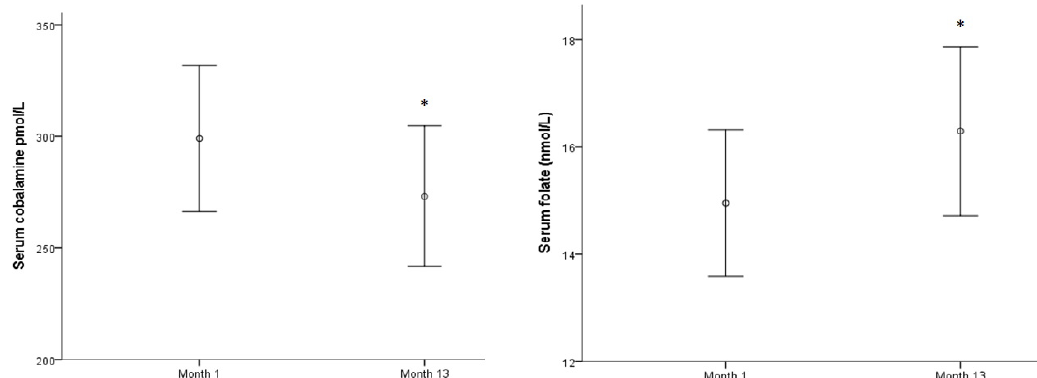
Figure 2. Serum cobalamine and serum folate evolution along a year.